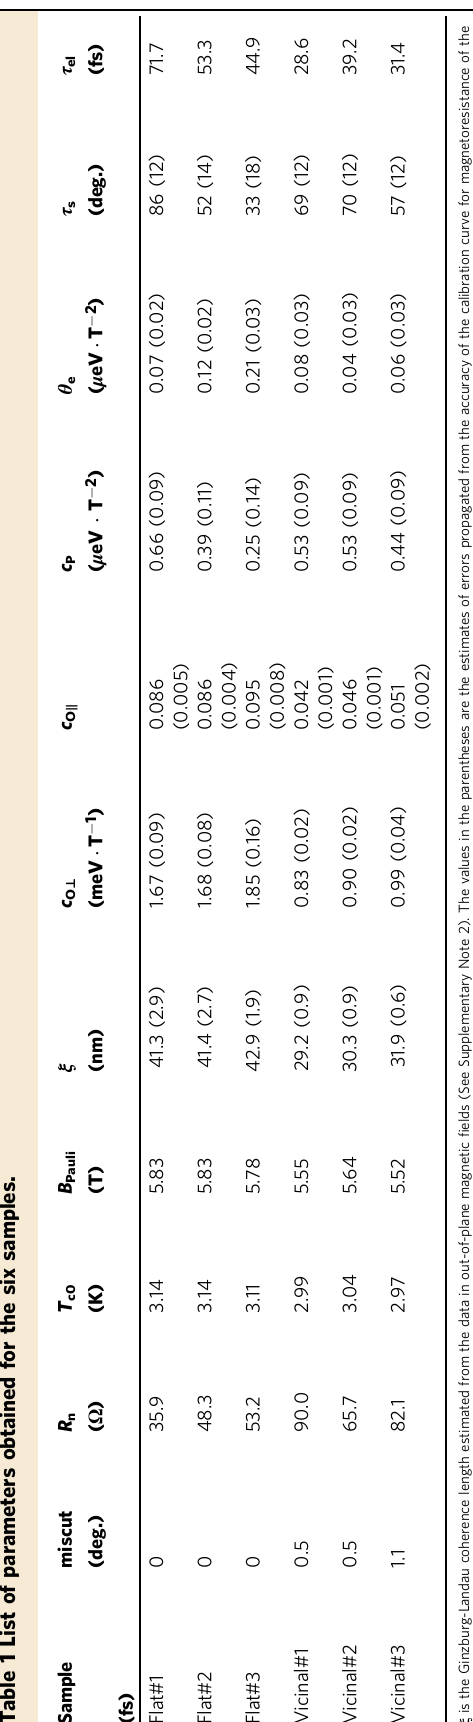
ffiffiffi p ffiffiffi p ´ 7 3